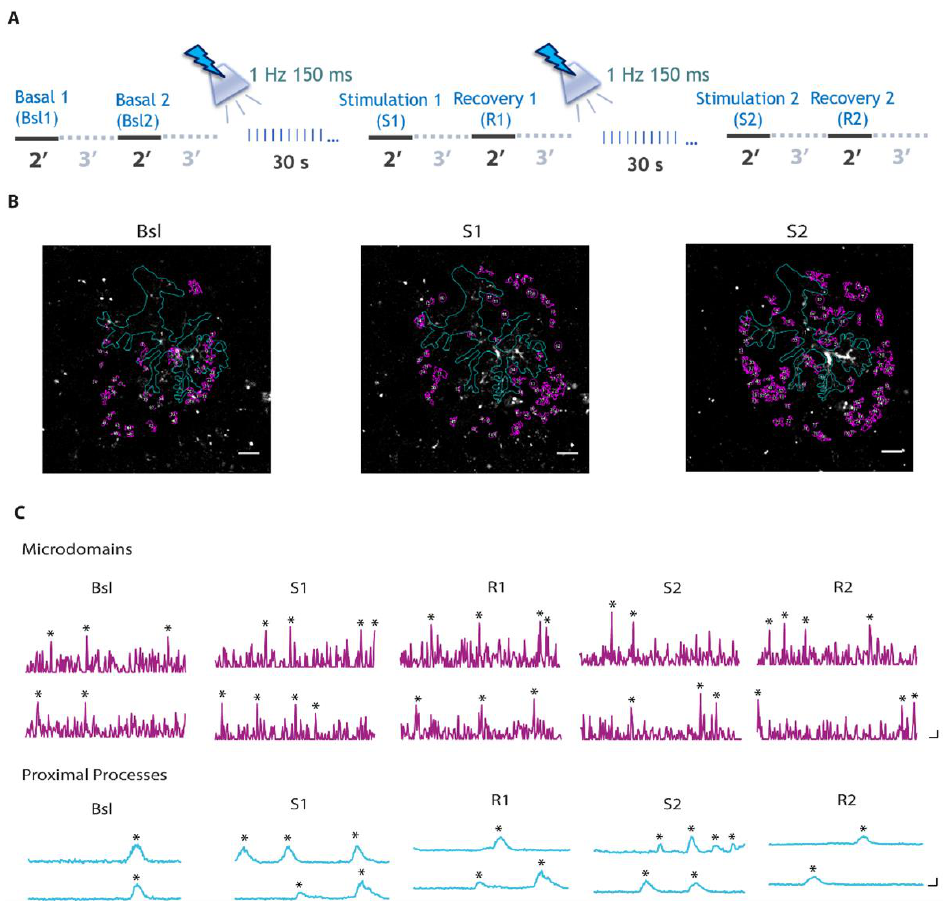
Figure 2. Combined Ca 2+ imaging in astrocytes and optogenetic stimulation of SST interneurons. ( A ) Calcium imaging 2 min recording protocol in astrocytes before and after optogenetic stimulation of SST interneurons with two successive 30 light pulse stimulations. ( B ) 2-photon fluorescence images of a representative GCaMP6f-expressing astrocyte in layer II/III VCx from a SST-Cre mouse at different time points. ROIs defined by GECIquant plugin of Image J (see Section 2 for details) are shown in violet for microdomains. In cyan, astrocytic main structure reconstruction from t-series maximal projection. Scale bar, 10 μ m. ( C ) Representative Ca 2+ signal dynamics at different astrocytic compartments before and after successive 30 light pulses. * indicate significant Ca 2+ peaks detected in a semi-automated manner by a MATLAB script [27]. Scale bars, 10 s, 2 Δ F/F 0 .